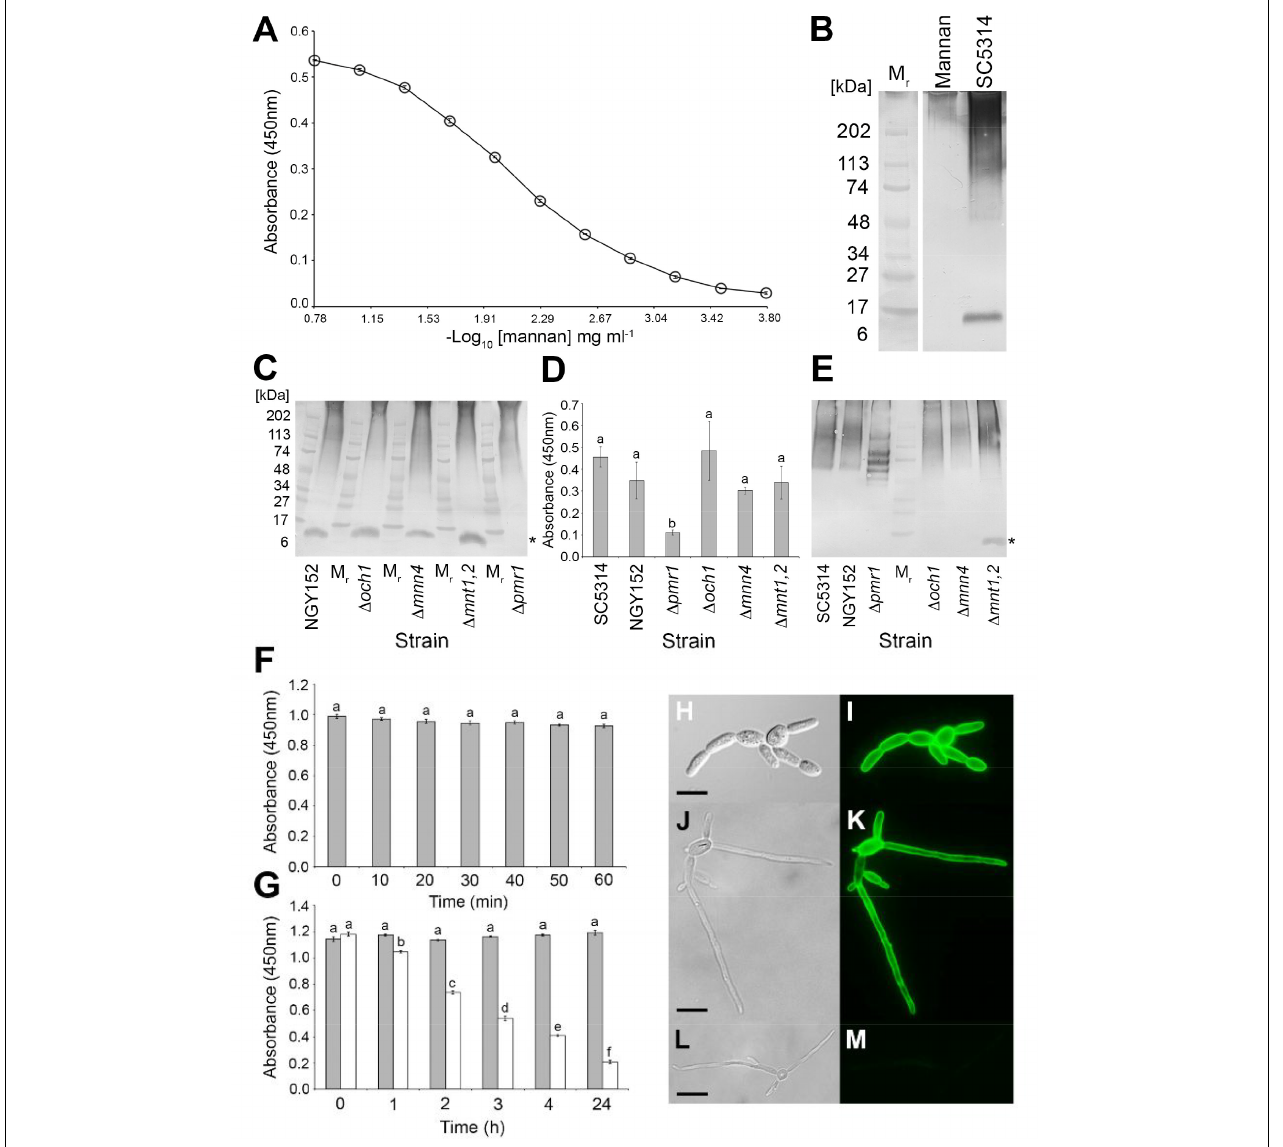
FIGURE 2 | Characterisation of the MC3 antigen, its epitope and spatial distribution in yeast and pseudohyphal cells. (A) ELISA absorbance values at 450 nm for purified C. albicans cell wall mannan. Each point is the mean of three replicates ± standard errors. (B) Western immunoblot with MC3 using purified C. albicans cell wall mannan (Mannan) and soluble antigens extracted from immunogen of C. albicans SC5314 (SC5314). Wells were loaded with 1.6 µ g of protein. M r denotes molecular weight in kDa. (C) Western immunoblot with MC3 using soluble antigens in surface washings of the C. albicans wild-type strain NGY152 and the mannan mutant strains. Wells were loaded with 1.6 µ g of protein. The asterisk ( ∗ ) indicates the low molecular weight band of ∼ 12 kDa, assumed to be PLM, which is absent in extracts from the (cid:49) pmr1 mutant. (D) ELISA absorbance values at 450 nm for culture fluids from the C. albicans wild-type strains SC5314 and NGY152 and the mannan mutant strains. Wells were coated with 60 µ g protein/mL buffer. Each bar is the mean of three biological replicates ± standard errors and bars with the same letter are not significantly different at p < 0.001. (E) Corresponding western immunoblot with MC3 using culture fluids from the C. albicans wild-type strains SC5134 and NGY152 and mannan mutant strains. Wells were loaded with 1.6 µ g of protein. The asterisk ( ∗ ) indicates the low molecular weight band of ∼ 12 kDa which is only present in culture fluids of the mutant (cid:49) mnt1,2. (F) ELISA absorbance values at 450 nm for heat-treated antigens from C. albicans SC5314. Wells were coated with 60 µ g protein/mL buffer. Each bar is the mean of three biological replicates ± standard errors and bars with the same letter are not significantly different at p < 0.001. There was no significant effect of heating on MC3 recognition, indicating that its antigen is heat-stable. (G) ELISA absorbance values at 450 nm for periodate-treated antigens (white bars) and control-treated antigens (gray bars) extracted from lyophilised cells of C. albicans SC5134. Wells were coated with 60 µ g protein/mL buffer. Each bar is the mean of three biological replicates ± standard errors and bars with different letters are significantly different from one another at p < 0.001. The significant reduction over time of MC3 recognition of periodate-treated antigens shows that the antibody’s epitope is carbohydrate and contains vicinyl hydroxyl groups. (H–M) Photomicrographs of C. albicans SC5314 blastospores and hyphae immunostained with MC3 (I,K) or TCM control only (M) followed by anti-mouse polyvalent Ig fluorescein isothiocyanate conjugate. Bright-field images of C. albicans SC5134 blastospores (H) and blastospores and hyphae (J,L) . (I–M) Same fields of view as (H–L) , but examined under epifluorescence. Scale bars = 4 µ m. Note the intense staining of cell walls of blastospores and hyphae with MC3 (I,K) , but lack of staining with TCM only (M) , demonstrating specific recognition of C. albicans yeast and hyphal cells by the antibody.